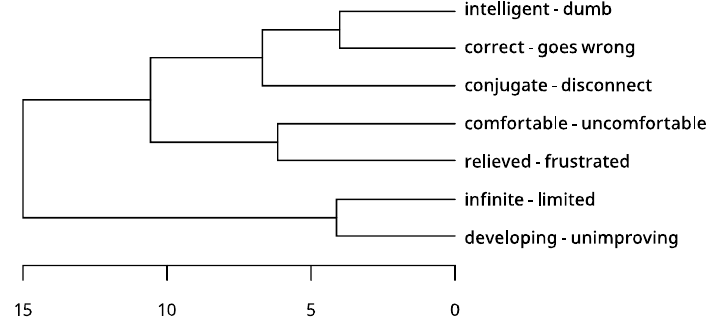
Figure 9. Result of HCA(P18). Figure 9. Result of